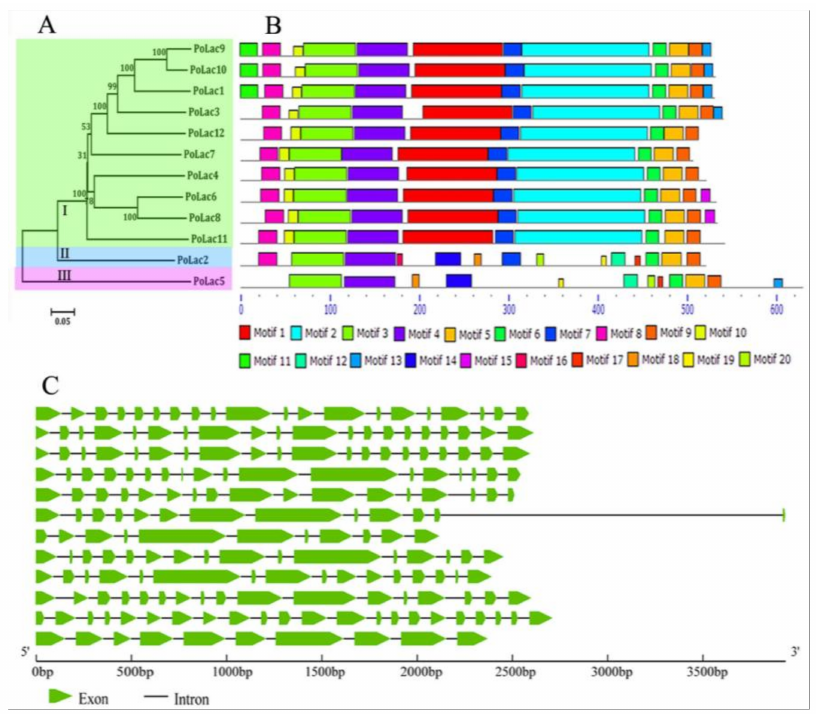
Figure 1. Phylogenetic analysis ( A ); conserved motif ( B ); and exon-intron structures ( C ) of P. ostreatus laccase gene